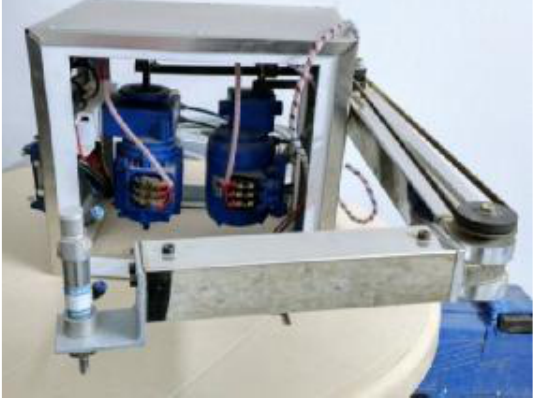
Fig. 12. Final SCARA Industrial Robot.